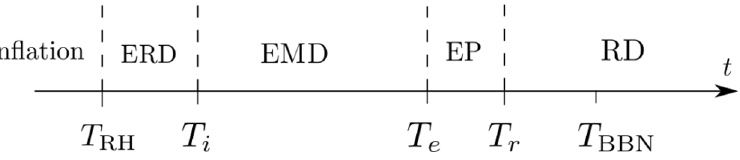
Figure 1 . The history of the Universe with an early matter era. After in(cid:13)ation and before the Big Bang Nucleosynthesis, which took place during a radiation-dominated (RD) era, we consider an early matter-dominated (EMD) era. It begins at some initial temperature T i which can be lower than the post-in(cid:13)ationary reheat temperature T RH , leaving the possibility of an early radiation- dominated (ERD) era. The EMD era ends at T e and leads to a period of entropy production (EP), which (cid:12)nishes at the reheat temperature T r